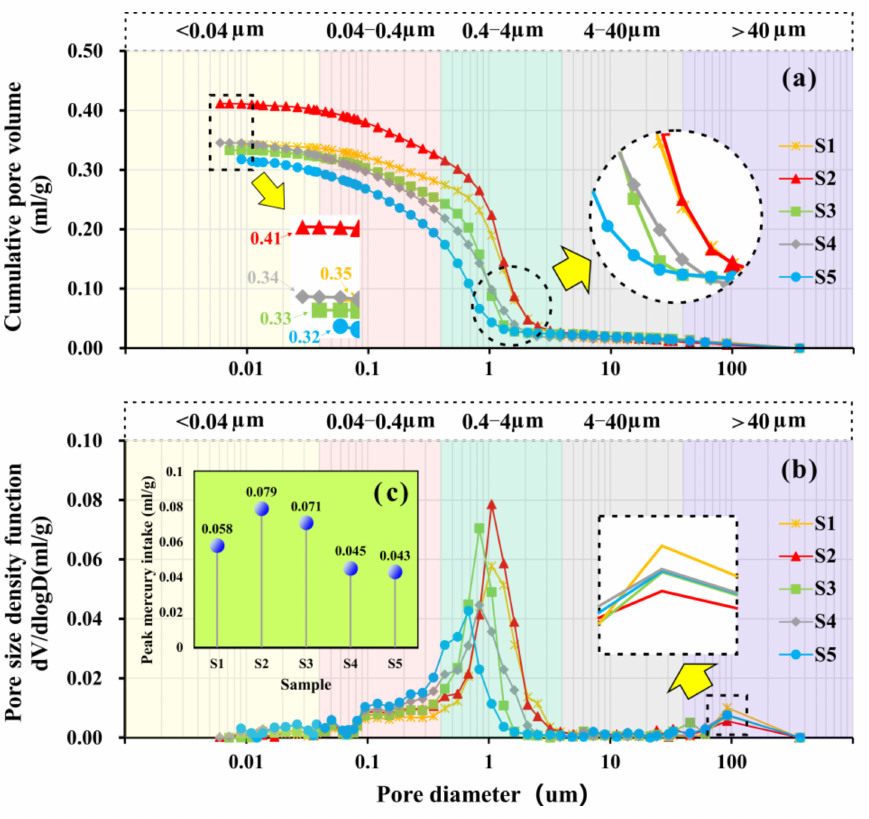
Figure 8. MIP results ( a ) cumulative pore volume curves; ( b ) pore size density function; ( c ) dominant pore peak